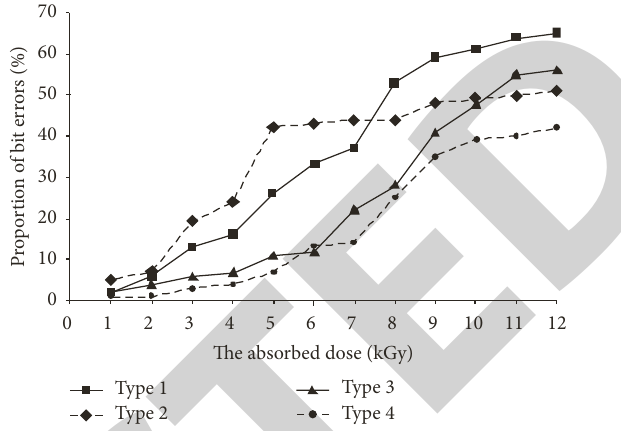
Figure 3: Registered percentage of bit errors depending on the absorbed dose for the four analyzed types of flash